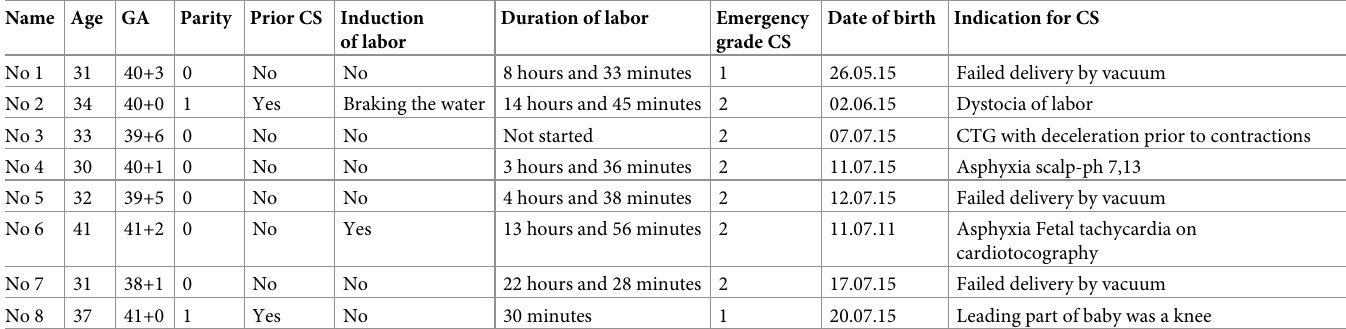
Table 1. Description of study population from